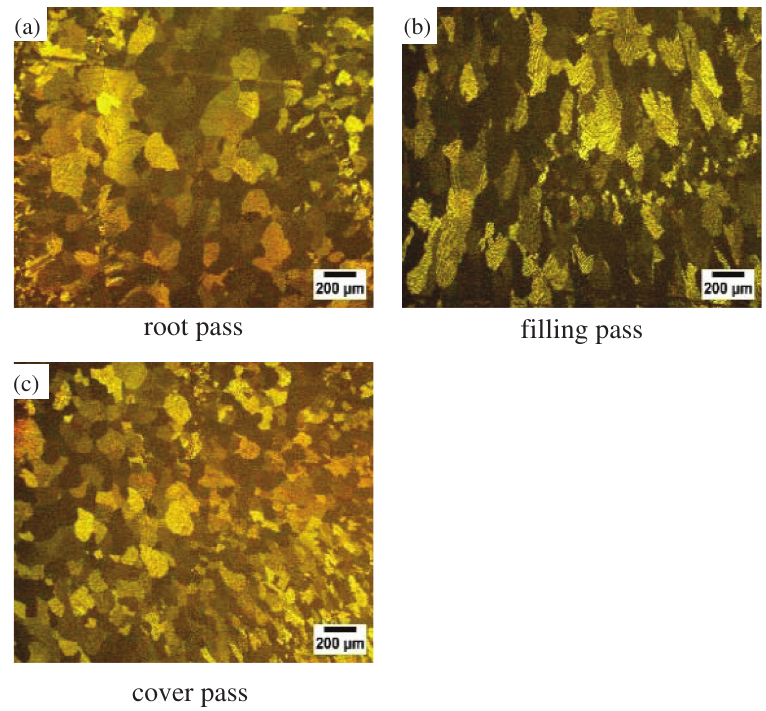
Figure 4: Microstructure of weld by